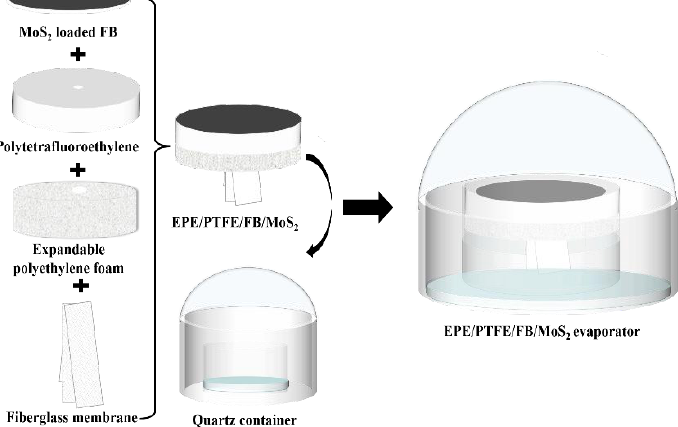
Figure 1. Schematic image of the fabrication process of the EPE/PTFE/FB/MoS 2